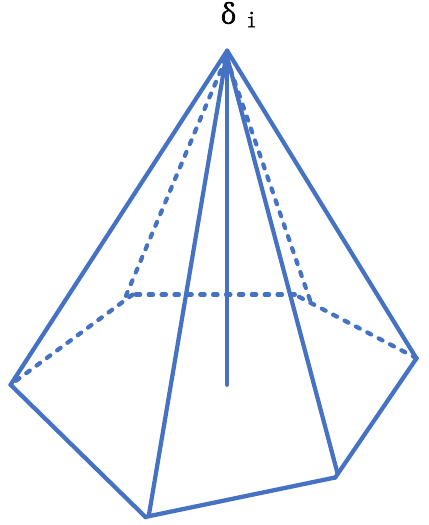
Figure 5. Geometry of Laplace operator.